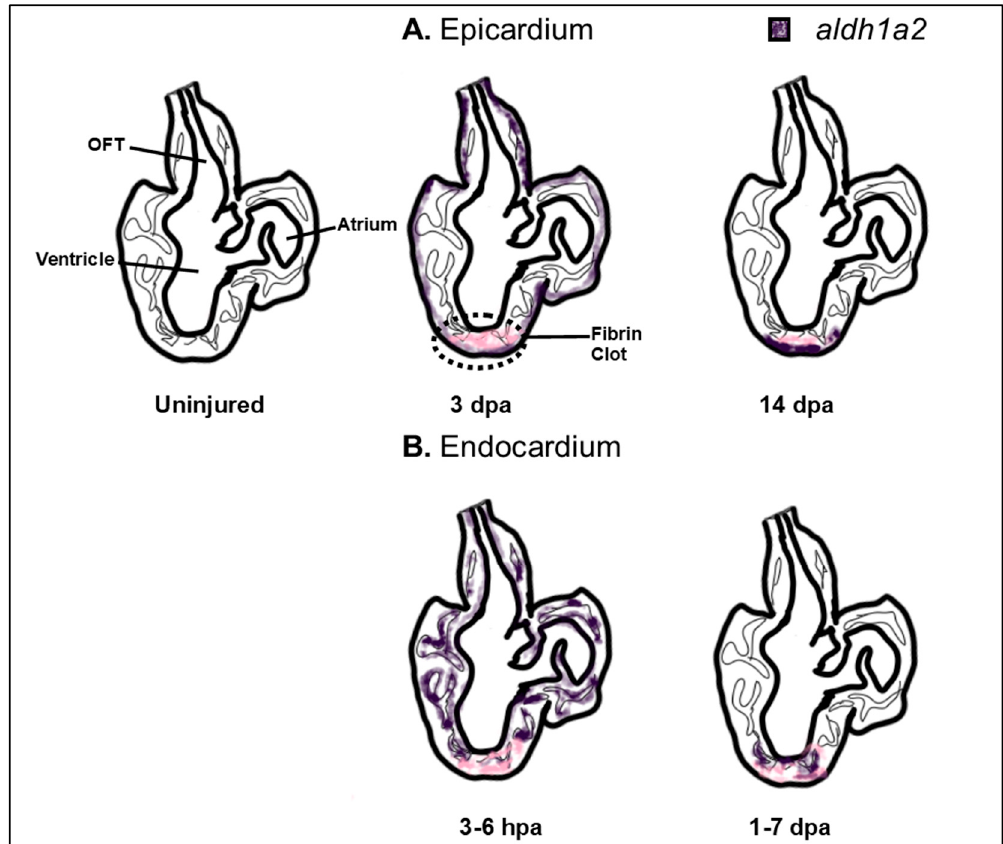
Figure 4. Cardiac proliferation and regenerative pathways are under the control of RA signaling. Schematic of aldh1a2 expression in an apical resection model of adult zebrafish; however, a similar response is seen from other injuries and albeit subdued, in murine models [177]. In response to injury, enhanced aldh1a2 expression is observed throughout the epicardium ( A ) and in the endocardium of both cardiac chambers ( B ). In the epicardium, aldh1a2 expression becomes restricted to the site of injury, concomitant with deposition of the first layers of new muscle which require the coordination of RA ‐ driven myocardial and epicardial events. Proper regeneration of the adult zebrafish heart requires RA synthesis from the endocardium as well, where RA synthesis rapidly becomes restricted to the site of injury as early as 24 h post ‐ amputation. Dpa: day post ‐ amputation, OFT: outflow tract.